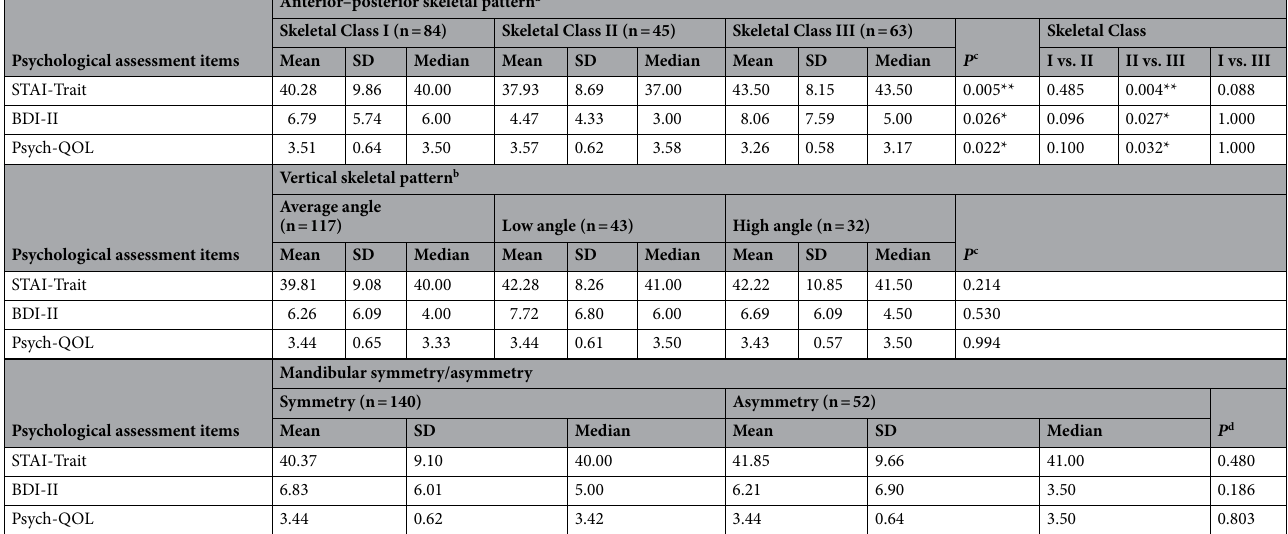
Table 2. Comparison of psychological assessments between groups classified by maxillofacial morphology. STAI State-Trait Anxiety Inventory, BDI-II Beck Depression Inventory-II, Psych-QOL psychological domain of the World Health Organization Quality of Life 26, SD standard deviation. a Classified by ANB angle as